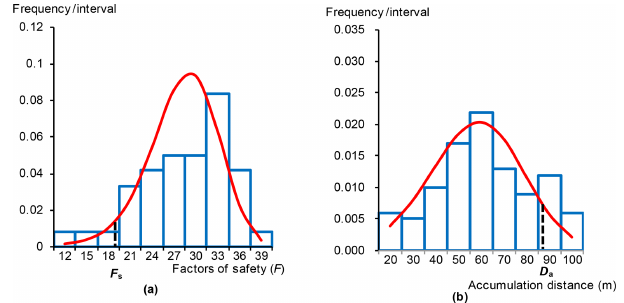
Figure 13. Statistical results of 100 slope models. (a) The final fac- tor of safety F s of the investigated rock slope; (b) the final accumu- lation distance D a of the investigated rock